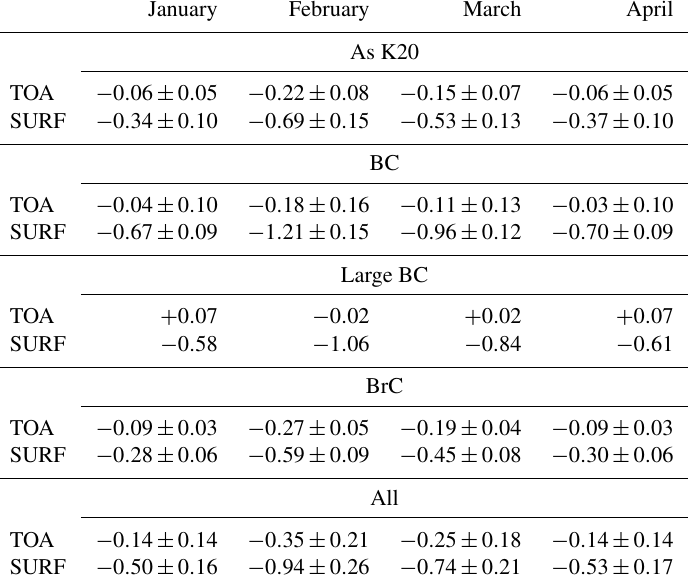
Table 1. Monthly mean area-weighted global-equivalent TOA and surface RF (in Wm − 2 ), for January to April 2020, for different scenarios of the unmeasured optical properties of the Australian fire plume. As K20: same assumptions of K20, SSA = 0 . 85–0.95 and g = 0 . 7. BC: black carbon, SSA = 0 . 80 and g = 0 . 5–0.7. Large BC: large black carbon, SSA = 0 . 80 and g = 0 . 7. BrC: brown carbon, SSA = 0 . 90–0.95 and g = 0 . 7. All: average of all scenarios, SSA = 0 . 80–0.95 and g = 0 .